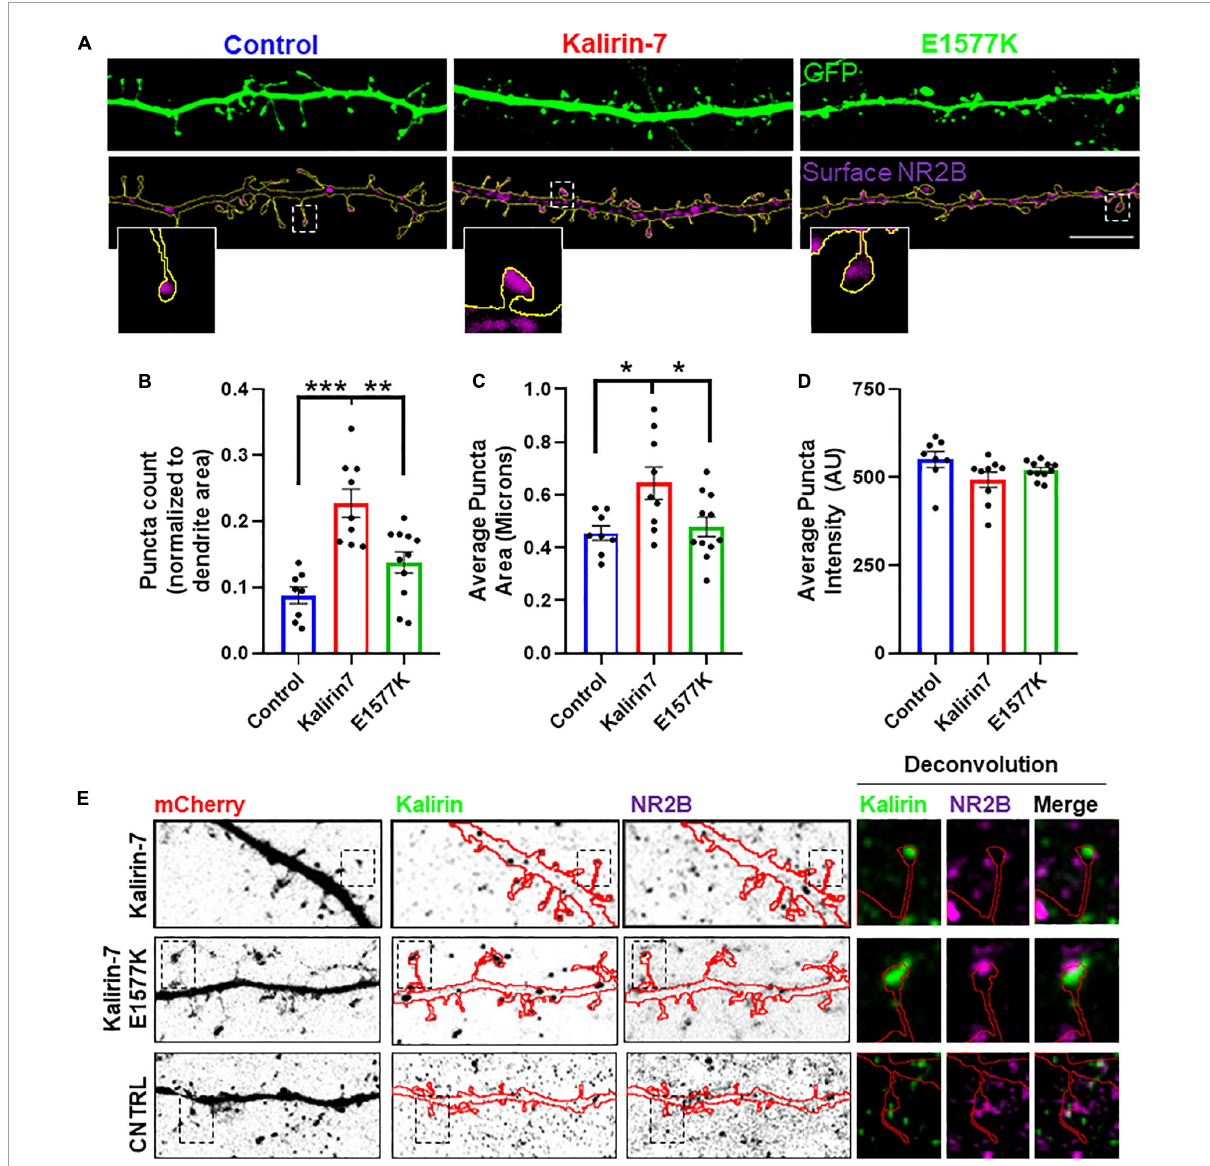
FIGURE4 E1577K impairs surface expression of NR2B . (A) Representative regions of secondary dendrites with GFP-cell fill and NR2B surface stain. Insets show a single spine from each condition. Scale bar -10 µ m. (B) Number of NR2B surface puncta normalized to total dendrite (GFP) area measured. (C) Average surface NR2B puncta size. (D) Average intensity of NR2B surface puncta. N = 2, 5 cells per replicate. (E) Regions of dendrites stained with Kalirin-7 and total NR2B to assess colocalization following overexpression of indicated constructs. Deconvoluted insets indicate Kalirin-7 and NR2B puncta adjacent within indicated spines. * p < 0.05. ** p < 0.01. *** p <